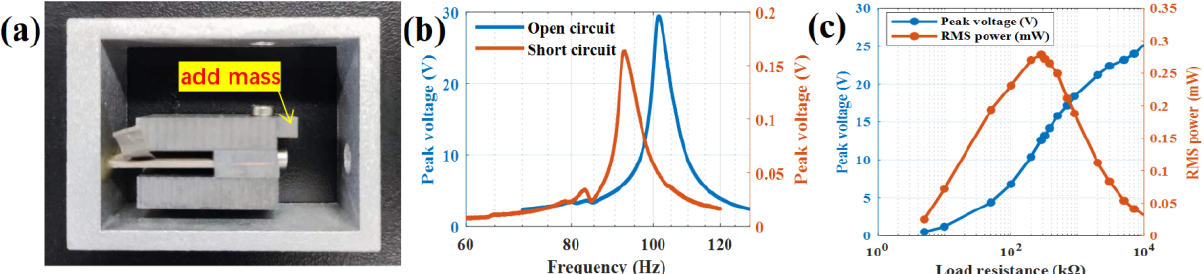
Figure 5. PVEH frequency modulation result by adding mass: ( a ) PVEH prototype with added mass; ( b ) PVEH experimental peak voltage frequency response curves at open-circuit (load resistance of 10 MΩ) and short-circuit (load resistance of 1 kΩ); ( c ) PVEH experimental RMS power in different load resistance at 100 Hz.